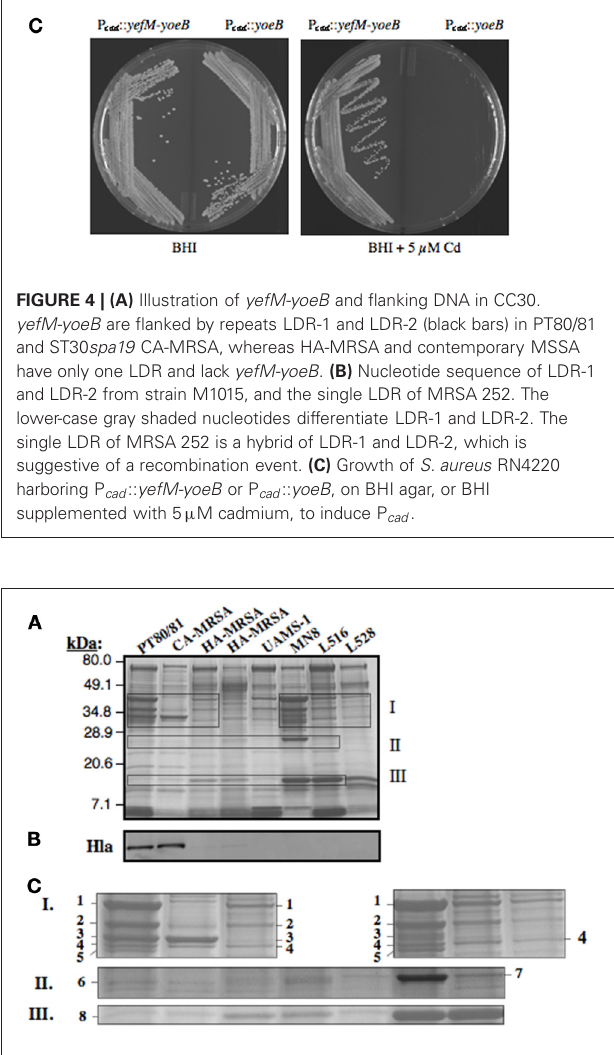
FIGURE 5 | Assessment of CC30 secreted proteins by SDS-PAGE (A) and Western blot for detection of Hla (B). The individual strains are the same as defined in Figure 3G . For visualization of secreted proteins by Coomassie Blue staining (A) , a total of 3.0 OD 600 units of cell-free culture supernatant was applied to each lane, while 0.02 OD units was applied in Figure 3B . Zones I, II, and III as outlined in the SDS-PAGE gel (A) are enlarged in Figure 3C . The numbered protein bands were excised from the gel, followed by trypsin digestion and mass spectrometry. The identity of proteins in each band is provided in Table 3